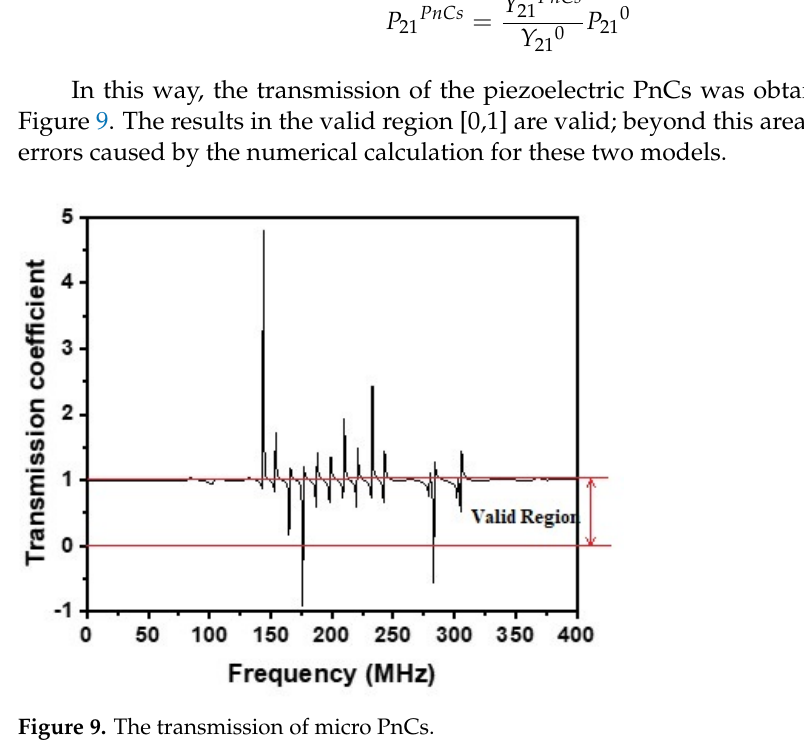
Figure 9. The transmission of micro PnCs.